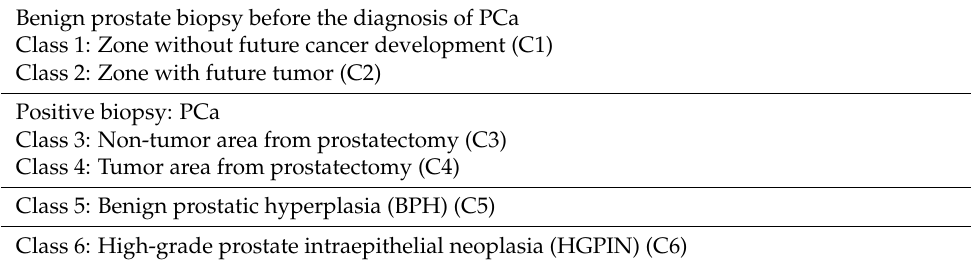
Table 3. Patient groups.